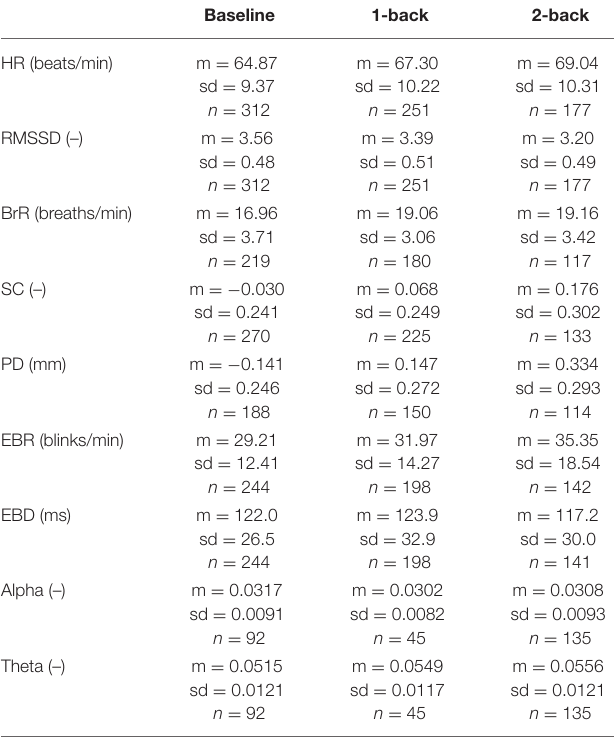
TABLE 2 | Measure